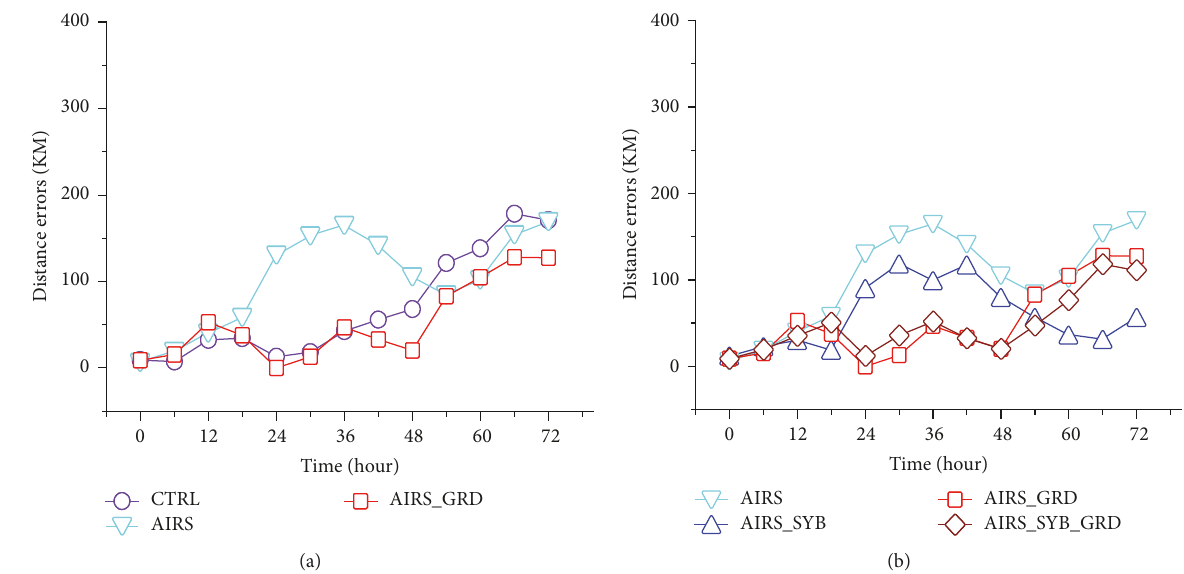
Figure 5: Track errors of the TC from experiments during the 72 h hindcast period without (a) and with systematic bias (b) (unit: